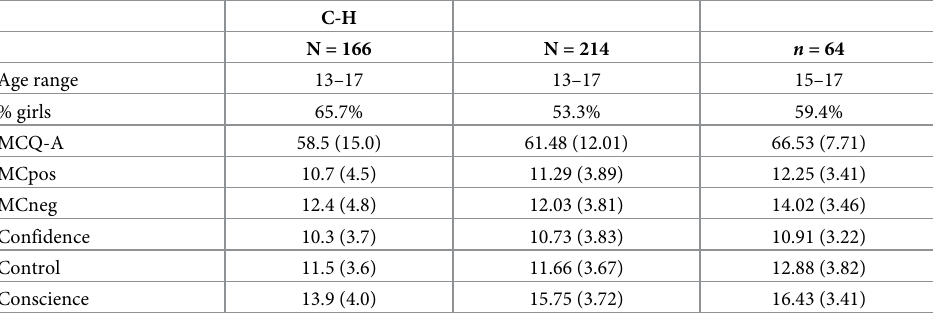
Table 1. Comparison of means and standard deviations (SD) of the 5 factors of the MCQ-A and MCQ-A total score.